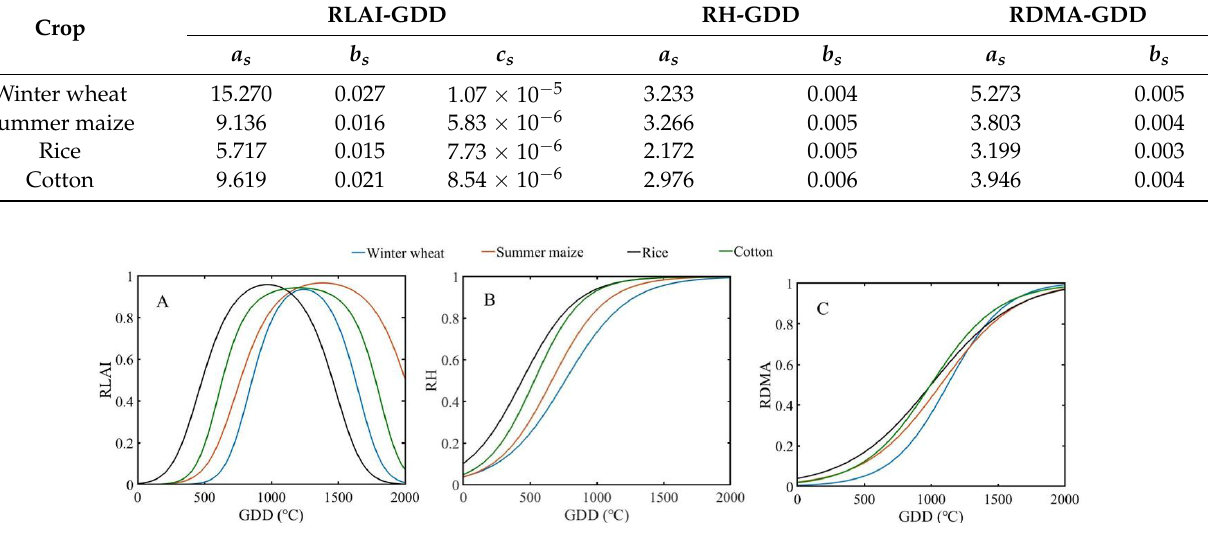
Figure 2. Semirelative logistic curves for each crop for ( A ) RLAI, ( B ) RH, and ( C ) RDMA.